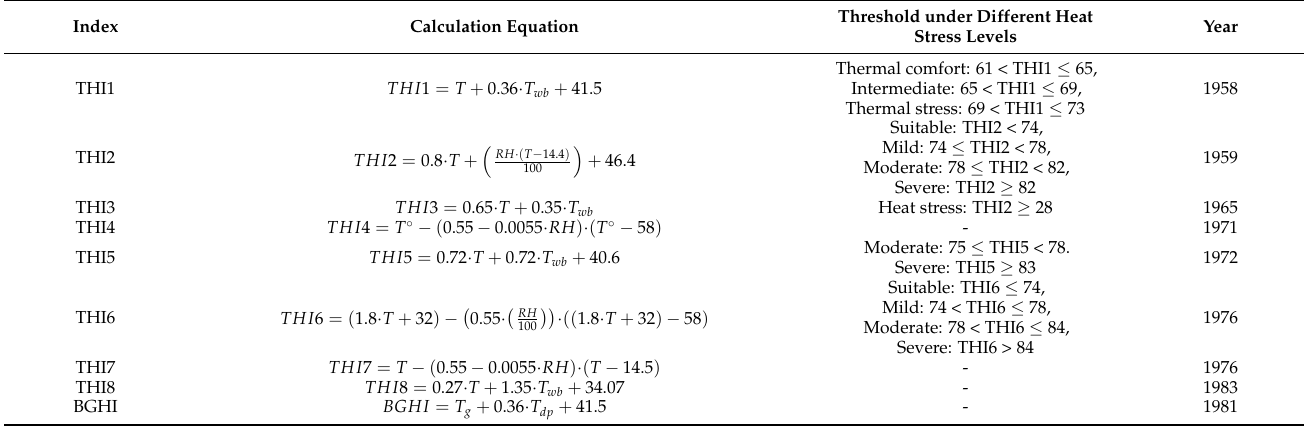
Table 1. Various thermal indices. Because there are many types of THI, a suffix of 1–8 is added for distinction. Among the various thermal indices, only some have threshold